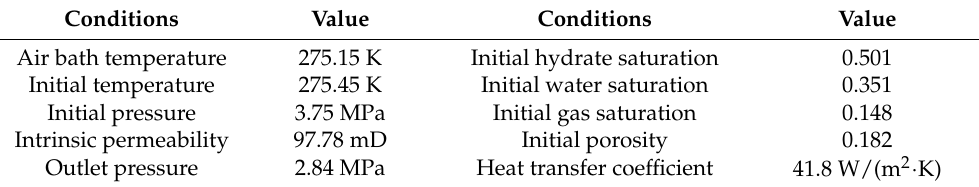
Figure 2. Schematic diagram of experimental setup. Table 2. Summary of the initial and boundary conditions of Masuda’s experiment.